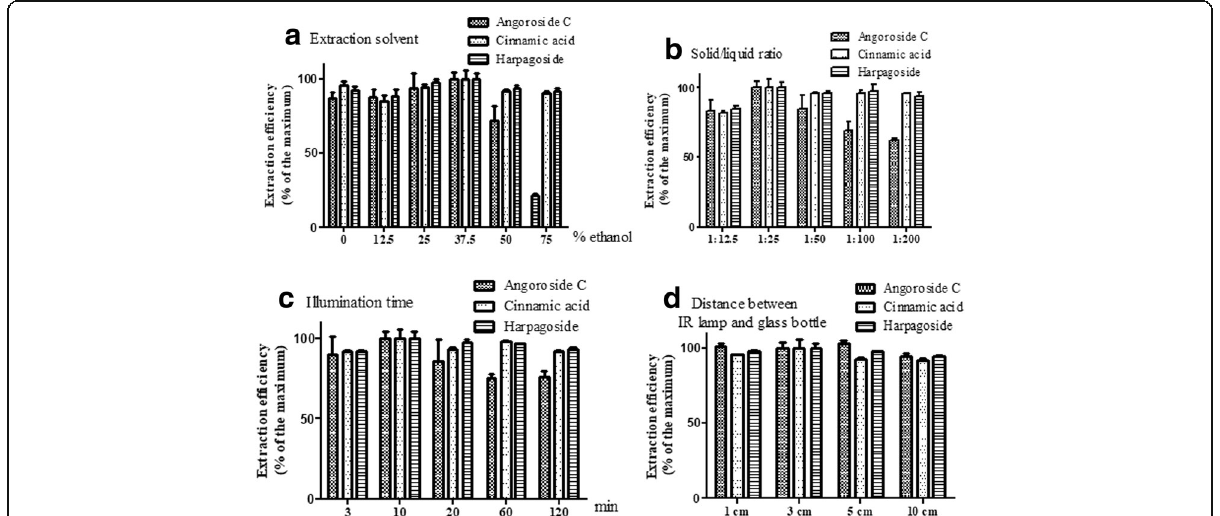
Fig. 3 Effects of the experiment parameters on extraction yield of angoroside C, cinnamic acid and harpagoside from S. ningpoensis in IRAE ( n =3). a Effects of solvent. Ratio of solid/liquid: 1:25; illumination time: 10min; the distance: 3cm. b Effects of solid/liquid ratio. Extraction solvent: 37.5% ethanol solution; illumination time: 10 min; the distance: 3 cm. c Effects of illumination time. Extraction solvent: 37.5% ethanol solution; Ratio of solid/liquid: 1:25; the distance: 3 cm. d Effects of distance between the IR lamp and glass flask. Extraction solvent: 37.5% ethanol solution; Ratio of solid/liquid: 1:25; illumination time: 10